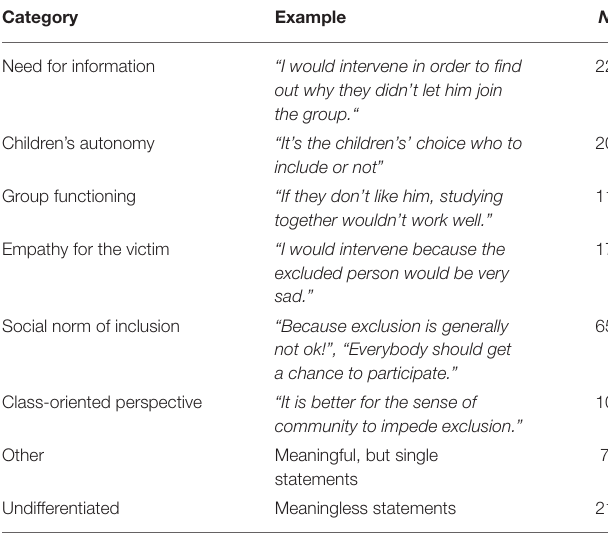
TABLE 1 | Coding system for justifications of likelihood of intervention and frequencies for each category.